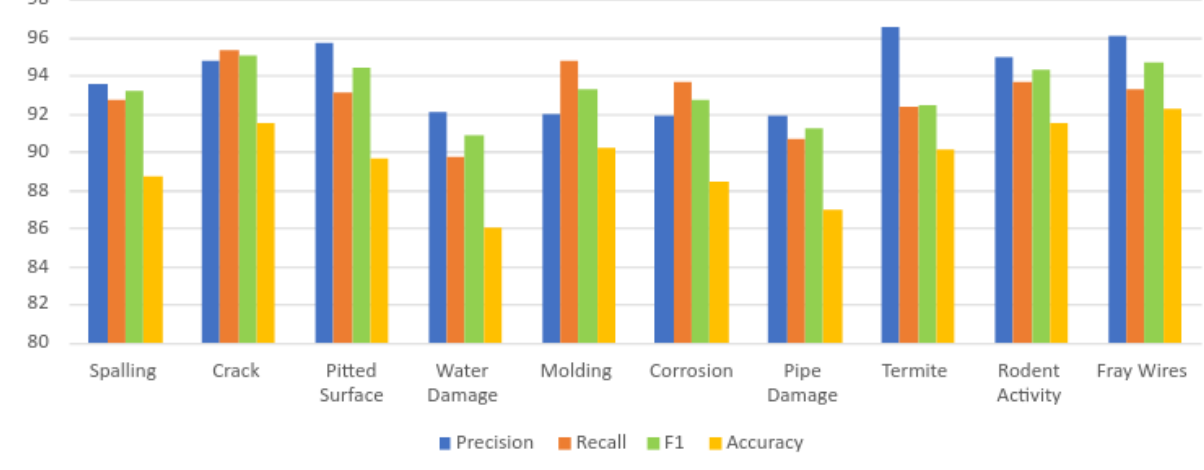
Figure 8. Graphical representation of the statistical measures of the proposed framework. Figures 9 and 10 show the Falcon robot in the prototype of the false ceiling (Oceania Robotics test bed), while Figure 11 shows the robot in a real false ceiling environment (SUTD ROAR Laboratory). During the inspection, the robot was controlled by a mobile GUI interface, and the robot’s position and the defect region were localized through UWB modules fixed in the false ceiling environment. The robot was paused at each stage for a few seconds to capture better quality images in these real-time field experiments.